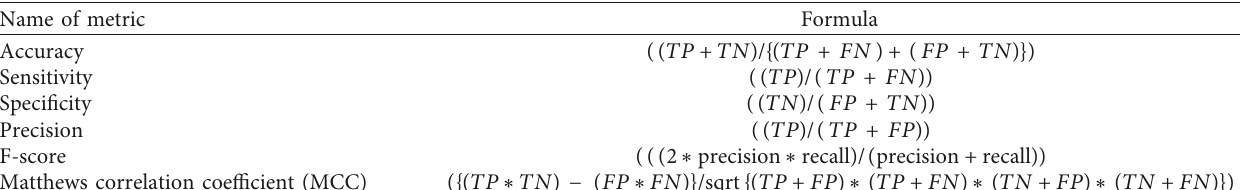
Table 5: Evaluation metrics.